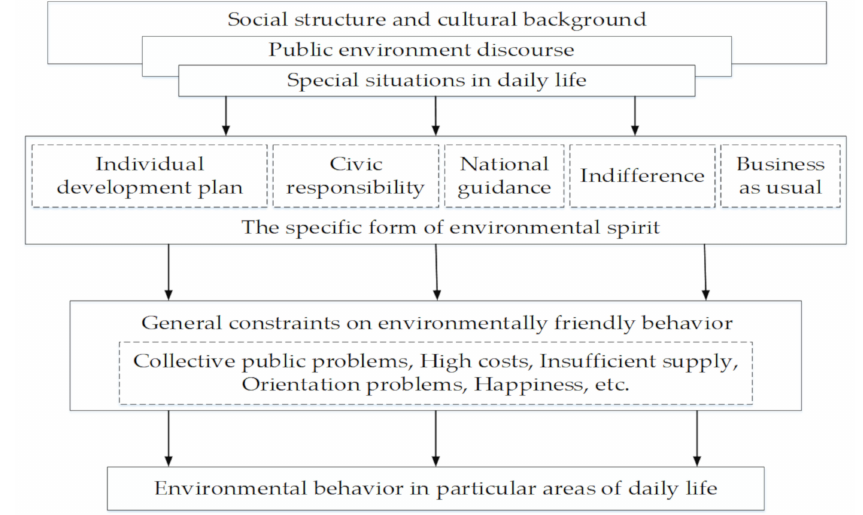
Figure 4. Context model for analyzing environmental consciousness and